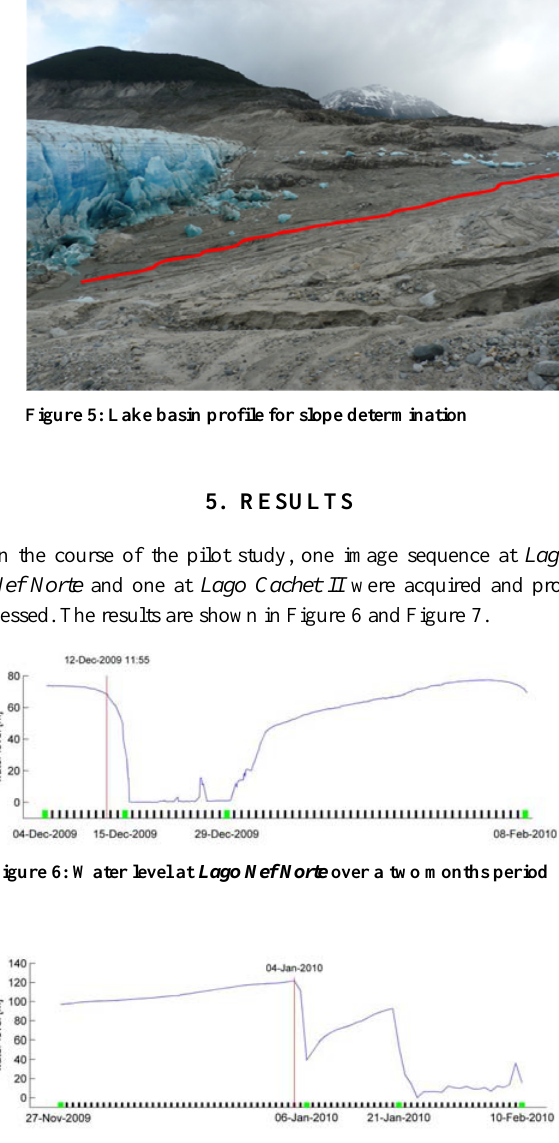
Figure 7: Water level at Lago Cachet II over a two months period At Lago Nef Norte , seven images per day were taken in two hour intervals between 4.12.2009 and 8.2.2010. At